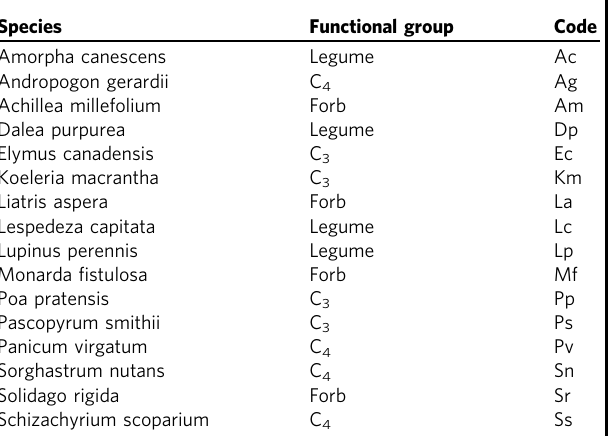
Table 1 Plant species and functional groups used in the plant-soil feedback and biodiversity-productivity